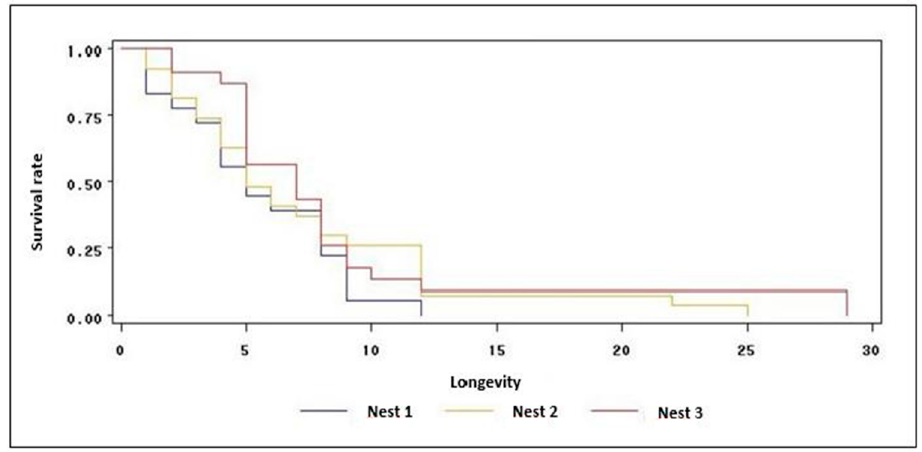
Figure 5. Survival analysis. Longevity survival function (weeks) of the Acromyrmex rugosus rugosus workers that emerged in three nests with different fungus volumes. Room temperature of 24 ± 2 °C and relative humidity of 70% ± 20%.